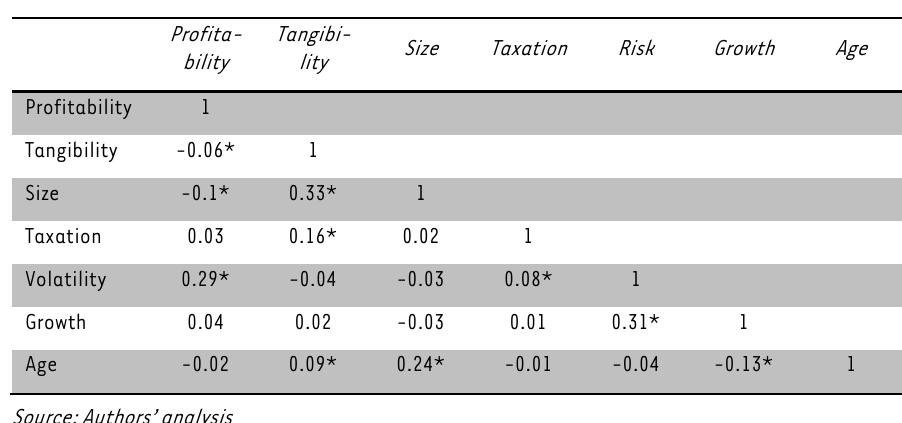
TABLE 1: Correlation